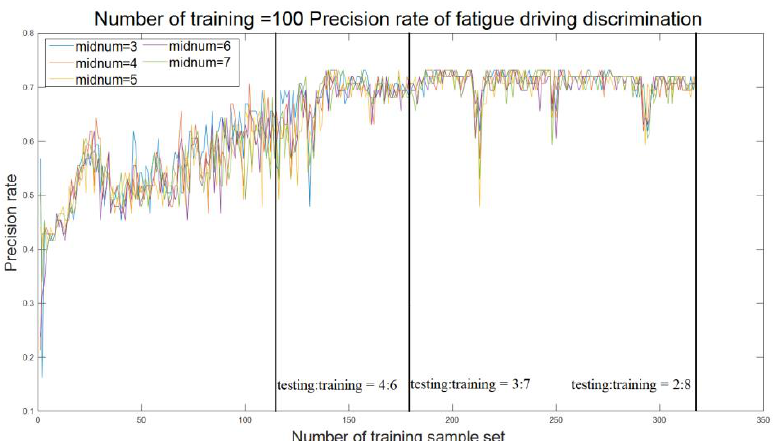
Figure 5. Accuracy of fatigue driving behavior detection varying with the number of training samples when the training times is 50.